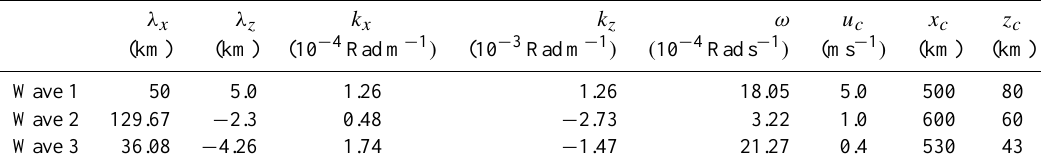
Table 1. Initial parameters of waves 1–3 regarded as initial perturbations in cases